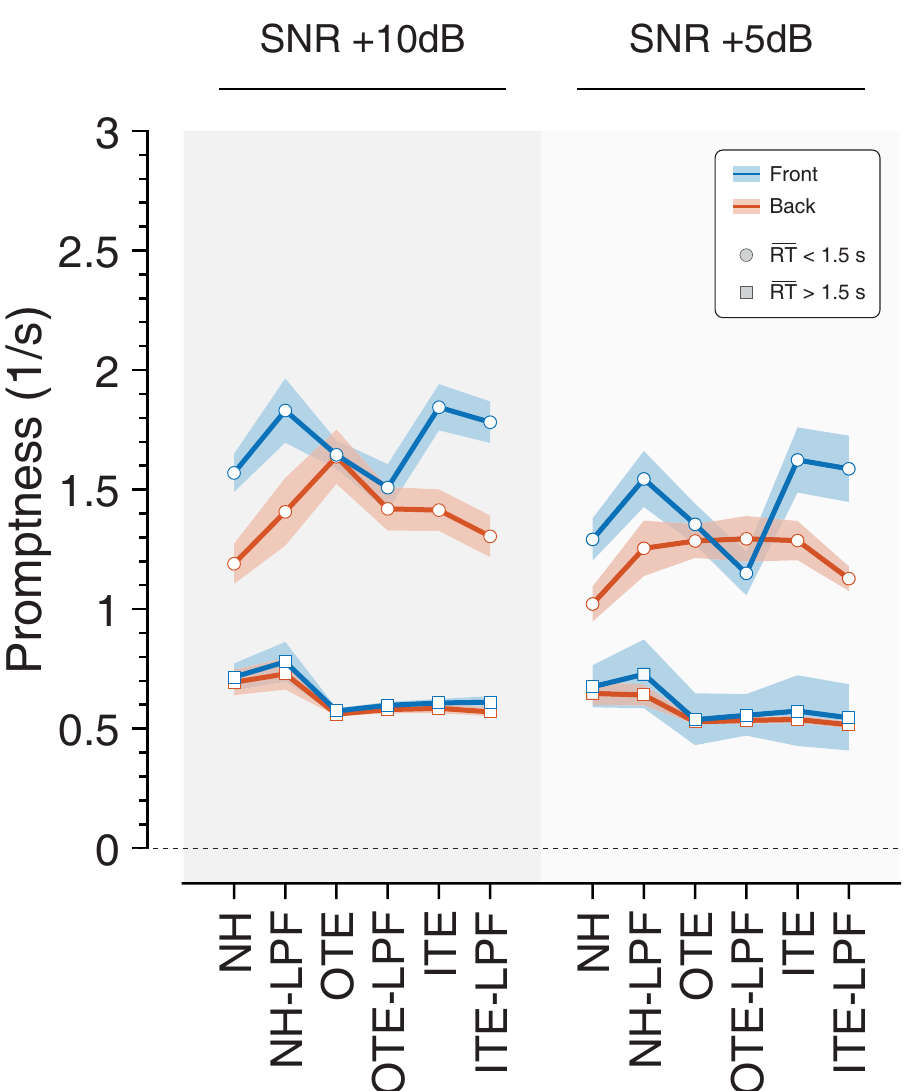
Fig 4. Mean response promptness (inverse of RT) across subjects for each listening condition, SNRs and font/back hemifields (blue/red, respectively). Shaded areas show standard error of the mean. Participants with measurable RTs are indicated by circles. Those participants whose average RTs across listening conditions exceeded a cutoff of 1.5 s are indicated by squares.